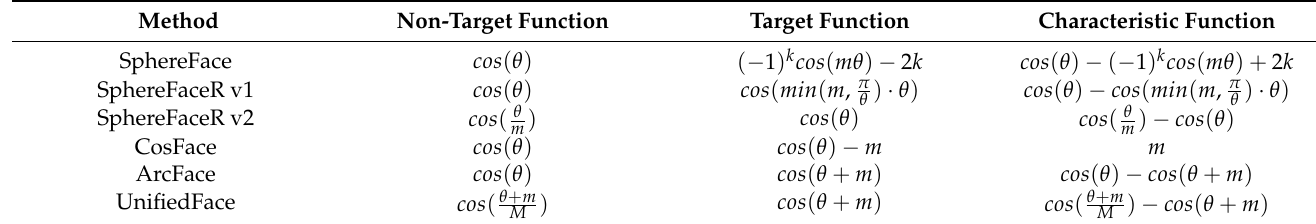
Table 2. Different margin − based loss functions for the characteristic